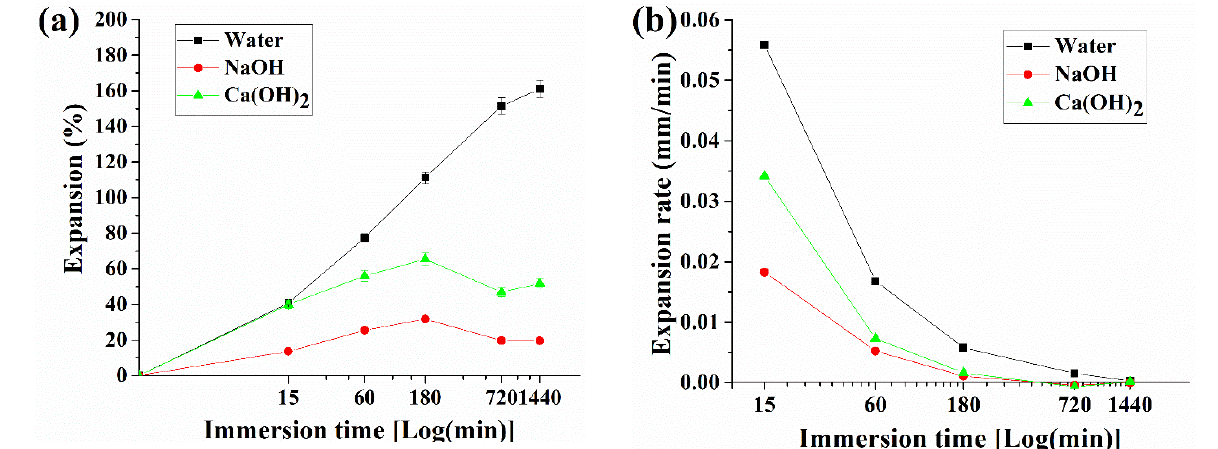
Figure 5. Expansion ( a ) and expansion rate through immersion time ( b ). The x-axis is time, expressed as the log of minutes.